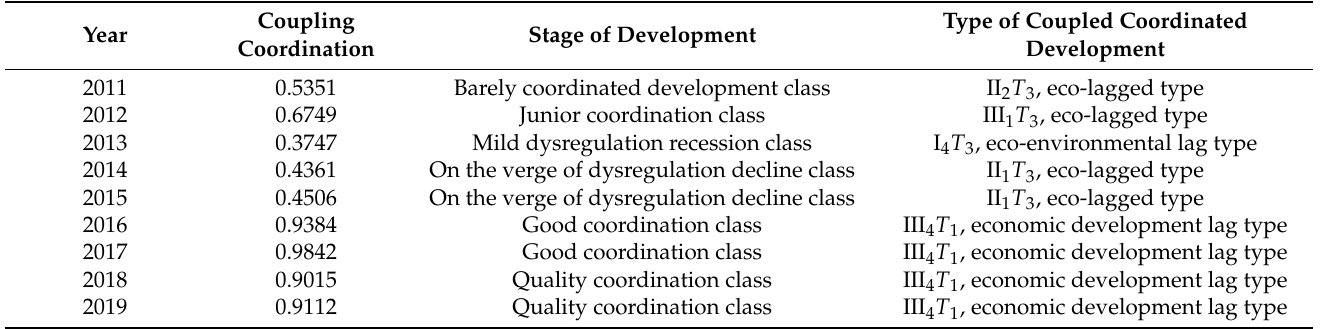
Table 4. The coupling coordination relationship between environment and economic development in key state-owned forest areas of Heilongjiang Province from 2011 to